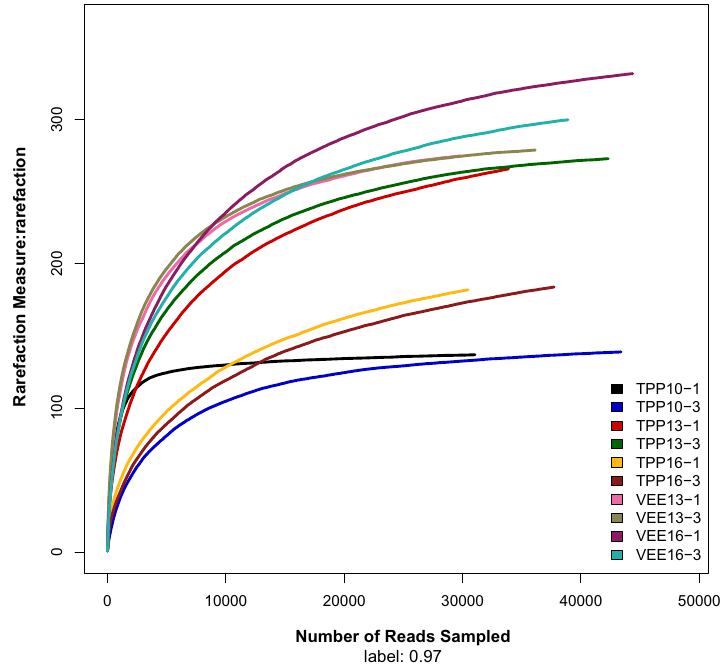
Figure 1. α-Diversity comparison. Rarefaction curves for OTUs were calculated using Mothur (v1.27.0) with reads normalized to more than 30,000 for each sample using a distance of 0.03 OTU.